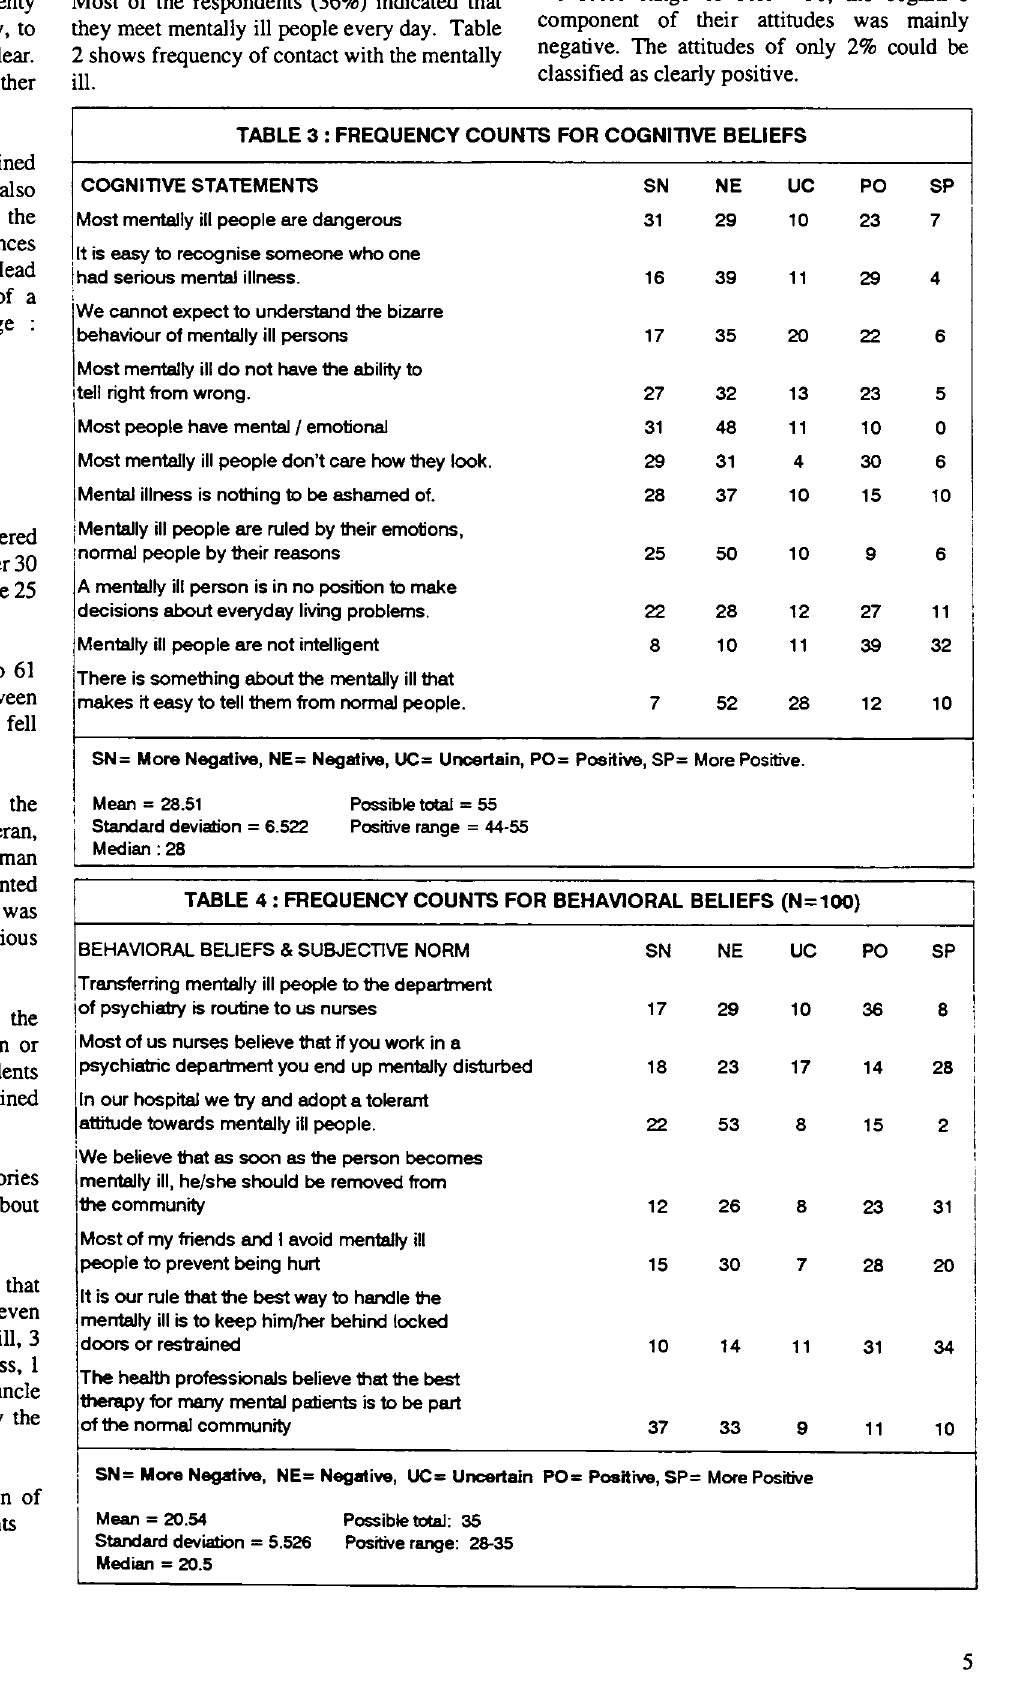
TABLE 2: FREQUENCY OF CONTACT WITH MENTALLY ILL PEOPLE ESTIMATED BY 100 RESPONDENTS Daily